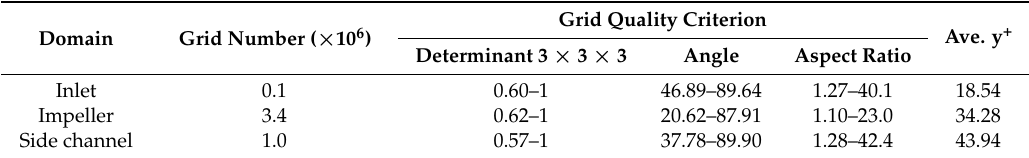
Figure 2. Computational grid domains. ( a ) inlet; ( b ) side channel and outlet; ( c ) impeller; ( d ) side channel interface. Table 3. Structured grid data for Grid